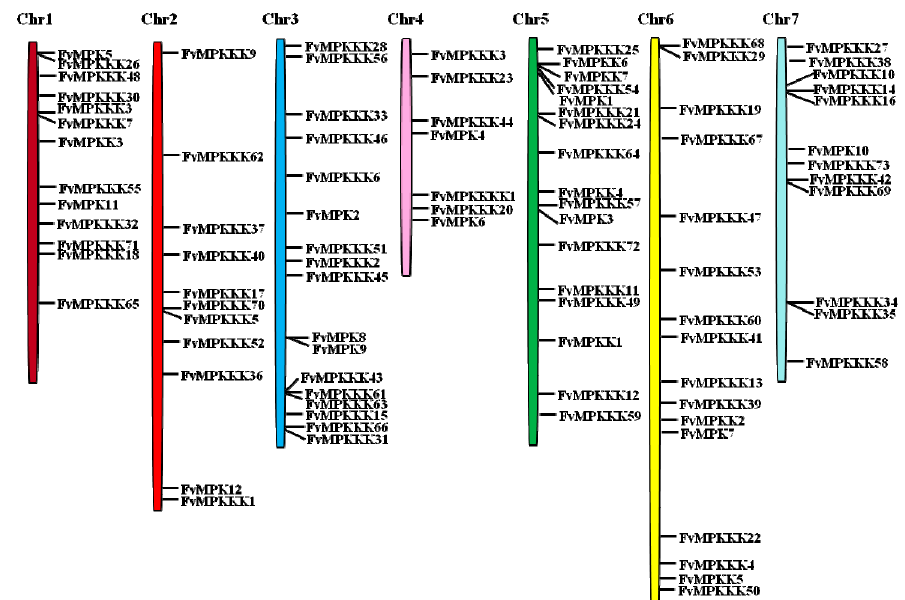
Figure 1. Chromosomal locations of strawberry MAPK , MAPKK , MAPKKK and MAP4K genes. Chr1–Chr7 represent the seven chromosomes. Black lines on bars indicate the locations of each gene.